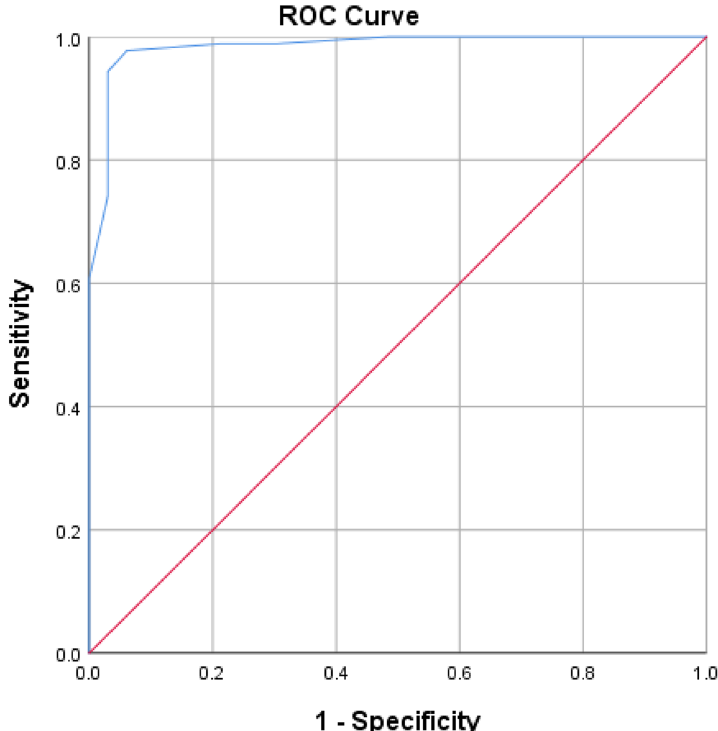
Fig. 2 Receiver operator characteristic (ROC) curve for the Malaysian Version of Score for Allergic Rhinitis (MySFAR)